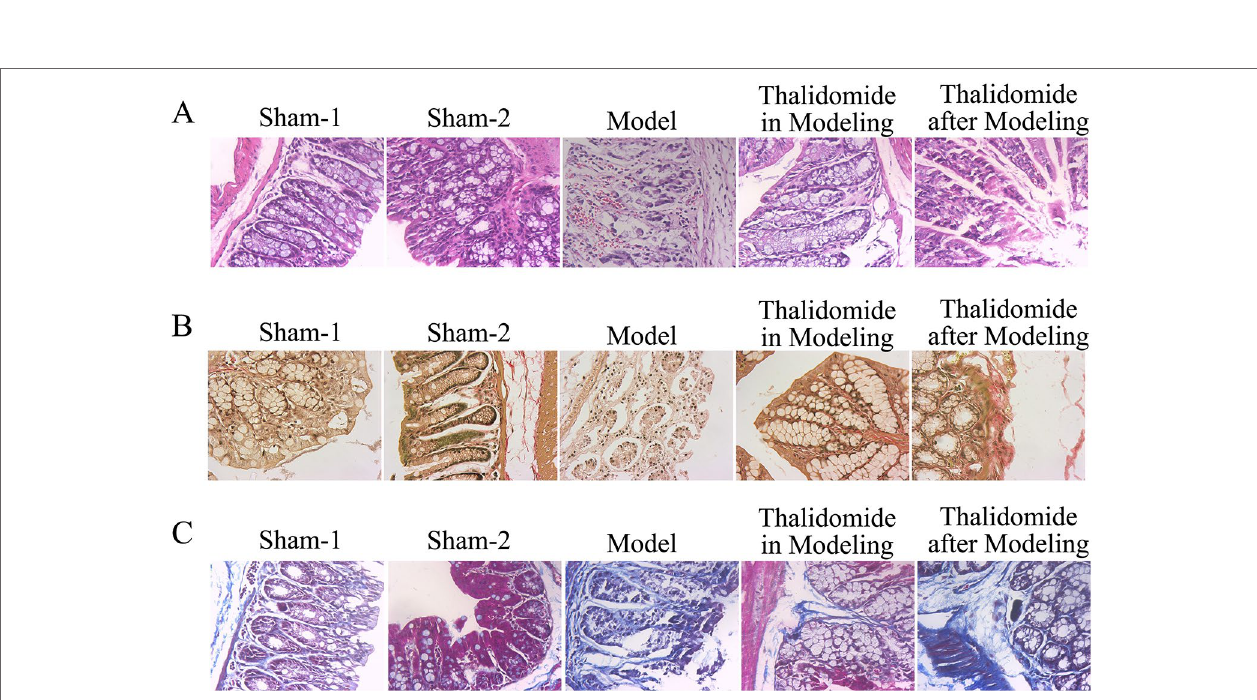
FIgURe 3 | Effects of thalidomide on the colonic histological alteration in mice induced with TNBS. (A) The severity of colonic inflammation of mice from different groups was evaluated by HE staining. Thalidomide treatment decreased the inflammatory infiltration induced by TNBS. (B , C) Fibrotic changes histopathologically of mice from different groups were determined by Masson’s trichrome staining and EVG staining assays, and thalidomide inhibited fibrosis in intestinal tissue. (100×).